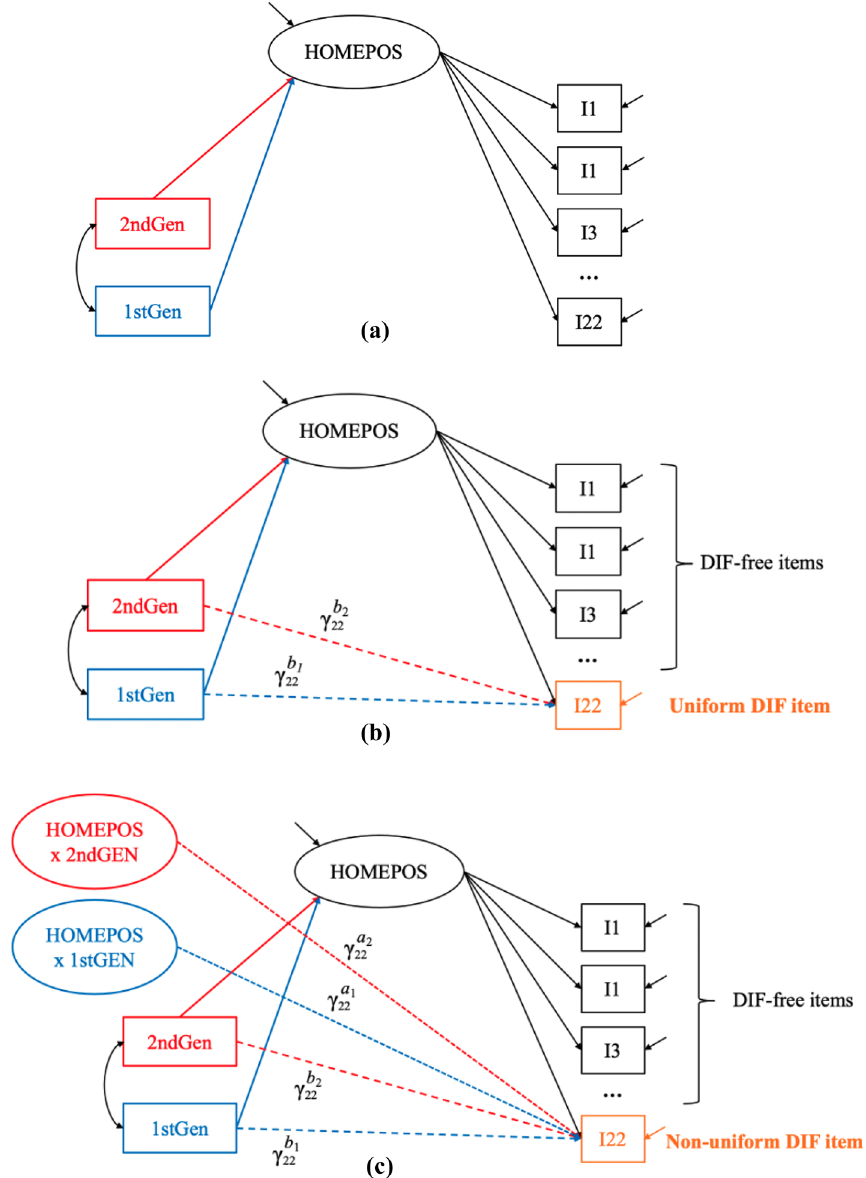
Fig. 1 Constrained baseline approach for DIF detection: a the baseline model with two covariates, 2ndGEN and 1stGEN (second-generation and first-generation immigrant student group variables); b the augmented model to test for uniform (threshold) DIF in the HOMEPOS items; c the augmented model to test for non-uniform (loading and threshold) DIF with two additional variables “HOMEPOS and “HOMEPOS 1stGEN” that represent the interactions between the latent variable HOMEPOS and two ×